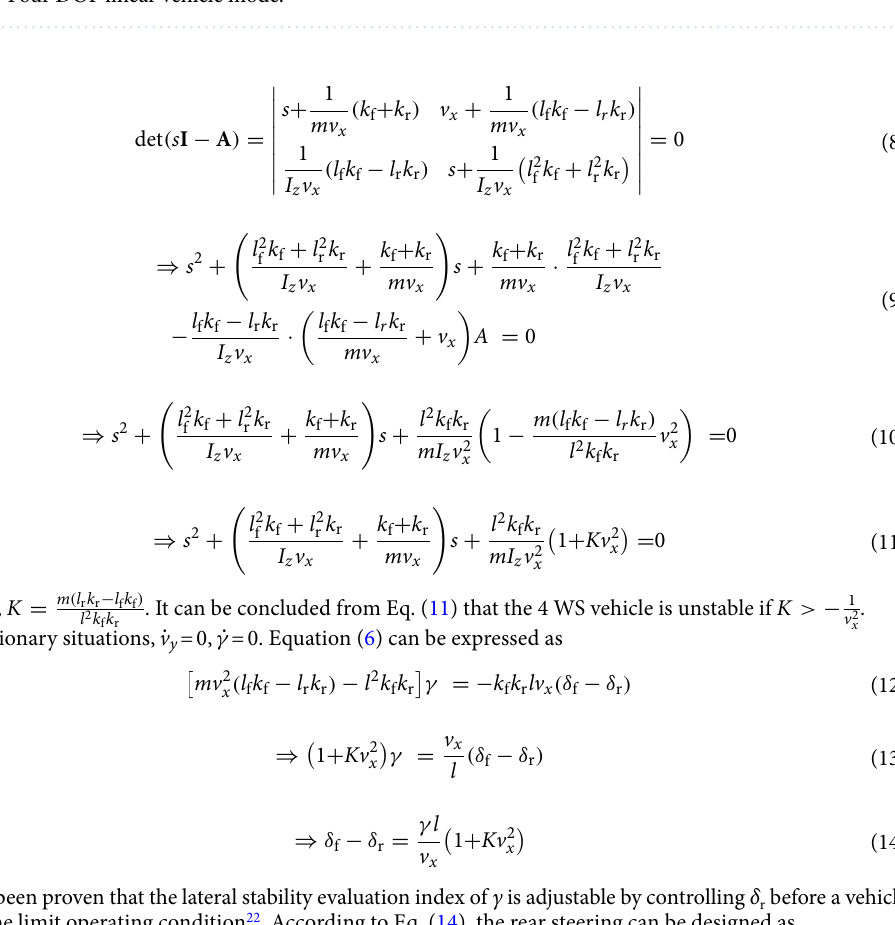
Figure 2. Four DOF linear vehicle